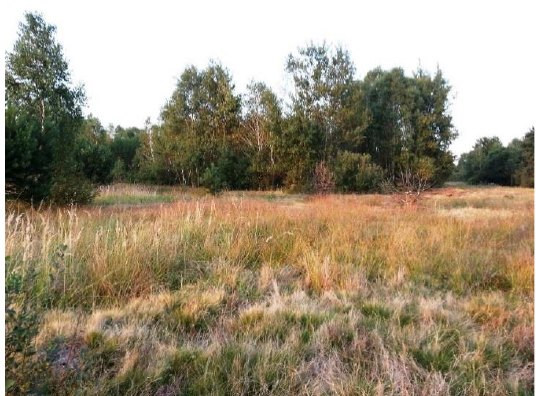
Figure 3. Dermacentor reticulatus collection site in Polesie National Park.